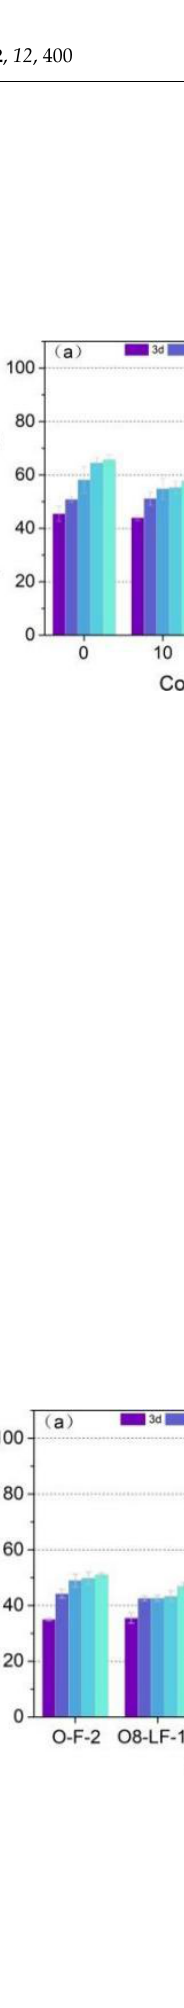
Figure 9. Compressive strength of OPC-LCFA-FA (20% LCFA + FA) samples. ( a ) Dry. ( b ) Water. Figure 10. Compressive strength of OPC-LCFA-FA (40% LCFA + FA) samples. ( a ) Dry. ( b ) Water. To sum up, the strength of the OPC-LCFA sample was higher than OPC-FA. The large specific surface area of LCFA allowed the absorption of water to form a water film.